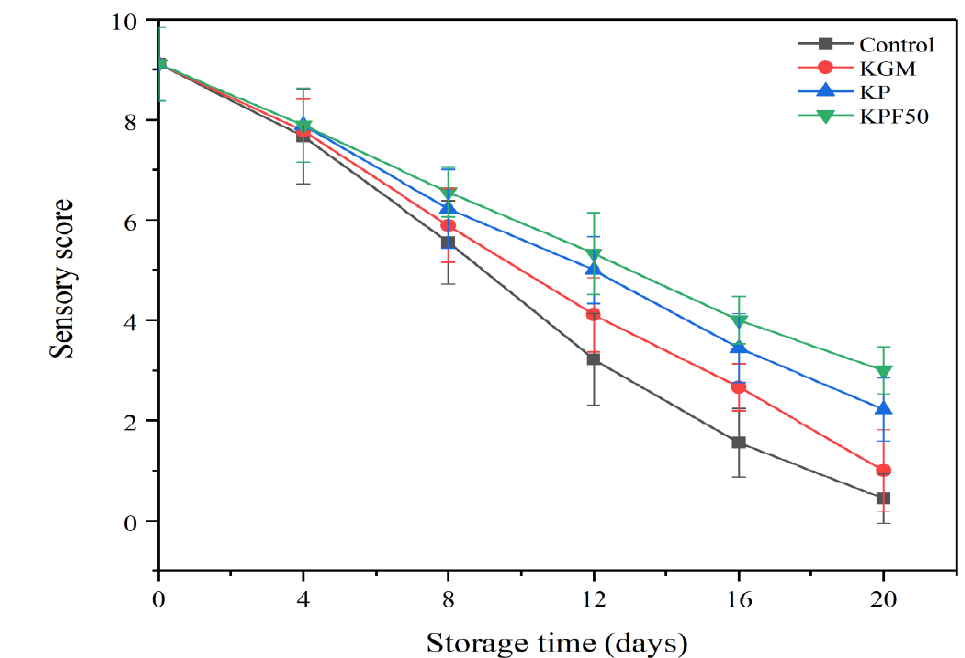
Figure 1. The sensory scores of sea bass fillets during refrigeration storage.